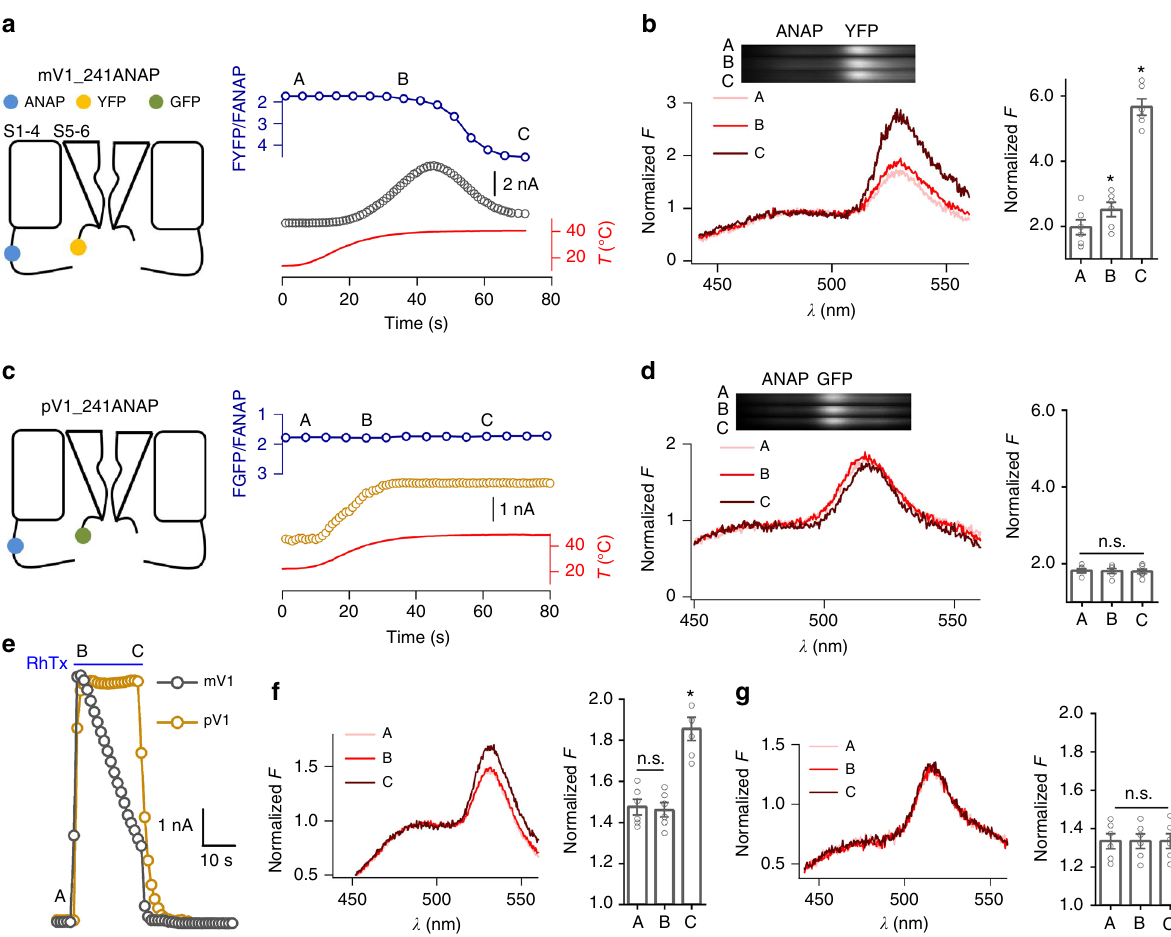
Fig. 3 Dh transition is required to the N – C direct interaction. a A schematic diagram showing the fl uorescence-labeled mV1 channel (left panel). Representative current and the YFP/ANAP ratio induced by a temperature ramp were recorded from HEK293T cells expressing mV1_241ANAP. Representative time course of Dh and the corresponding YFP/ANAP ratio recorded from a whole-cell patch are fi tted to a single-exponential function (right panel). τ -values of Dh and YFP/ANAP ratio are 12.4 ± 1.4 and 14.9 ± 1.4 s, respectively ( n = 3). b Spectral images of the cell (in a ) were acquired at points A, B, and C during electrophysiological recording (left panel). The corresponding spectra are normalized to the ANAP intensity and corrected by temperature-dependent FRET signals shown in Supplementary Fig. 3b (right panel, n = 6, two-sided t -test: * p < 0.01). c A schematic model of fl uorescence- labled mV1 channel (left panel). Simultaneous whole-cell current and fl uorescence recordings from pV1_241ANAP when the temperature is changed (right panel). d Spectral images of the cell (in c ) were acquired at points A, B, and C (left panel). The corresponding spectra are normalized to the ANAP intensity and corrected by temperature-dependent FRET signals illustrated in Supplementary Fig. 3d (right panel, n = 6, two-sided t -test: n.s., not signi fi cant). e Whole-cell recording from mV1_241ANAP and pV1_241ANAP in the presence of 10 μ M RhTx. f Fluorescence emission spectra of the cell (mV1 in e ) were recorded at time points A, B, and C during current recordings (left panel). The corresponding spectra are normalized to the ANAP intensity (right panel, n = 3, two-sided t -test: * p < 0.01; n.s., not signi fi cant). g Fluorescence emission spectra of the cell (pV1 in e ) were recorded at time points A, B, and C (left panel). The corresponding spectra are normalized to the ANAP intensity (right panel, n = 6, two-sided t -test: n.s., not signi fi cant). All statistical data are given as mean ± SEM. Source data are provided as a Source data fi